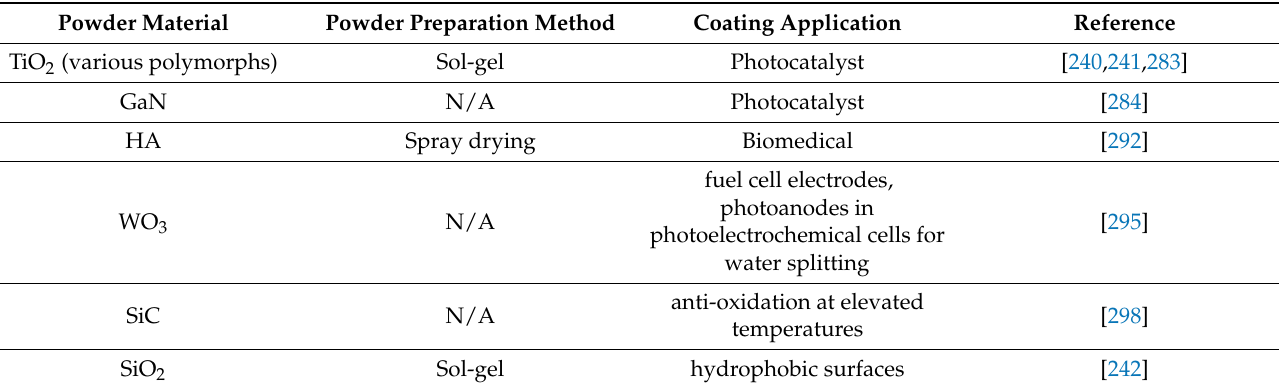
Table 4. Selected applications of the LPCS ceramic